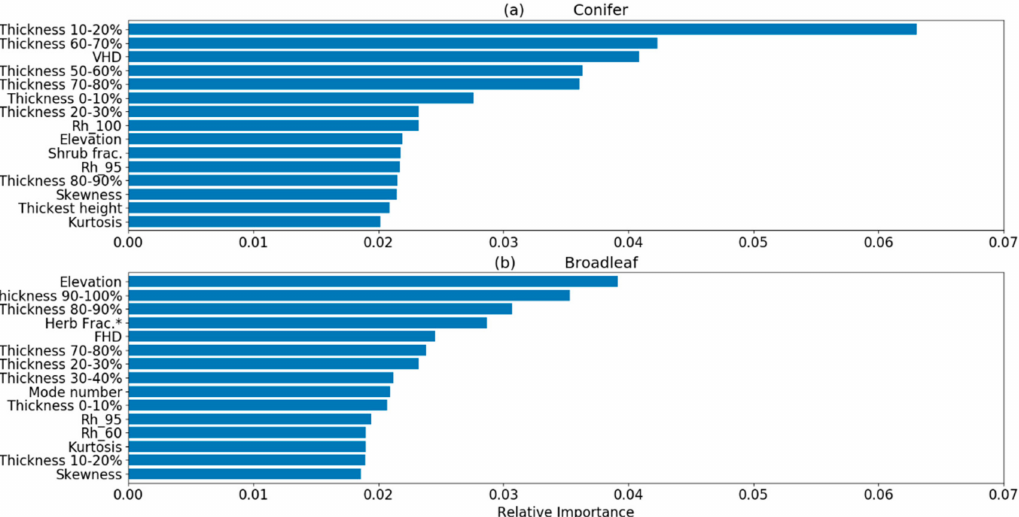
Figure 9. Feature importance of the top fifteen most important features for shapefile Random Forest classification for ( a ) Conifer and ( b ) broadleaf forest. * indicates the standard deviation of feature; FHD: Foliage Height Diversity, VHD: Vertical Height